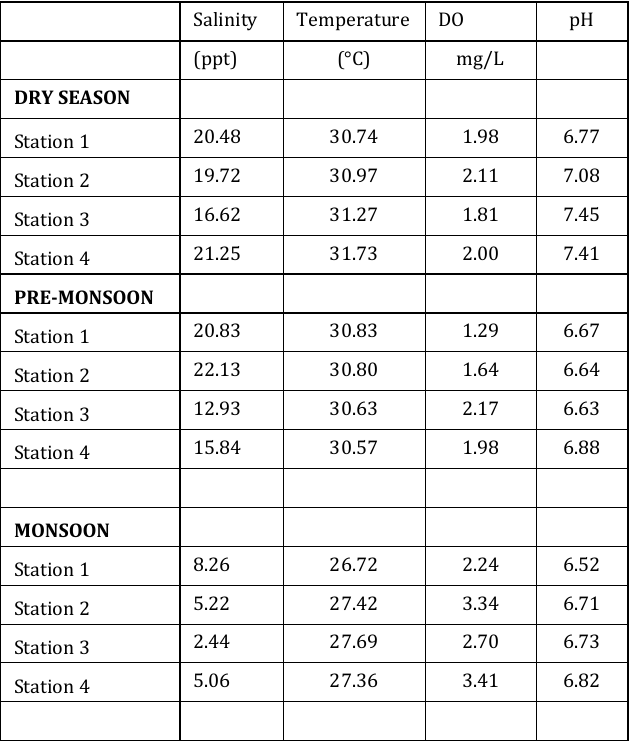
Table 2: Mean value of physico-chemical parameters at Tok Bali mangrove forest, Kelantan